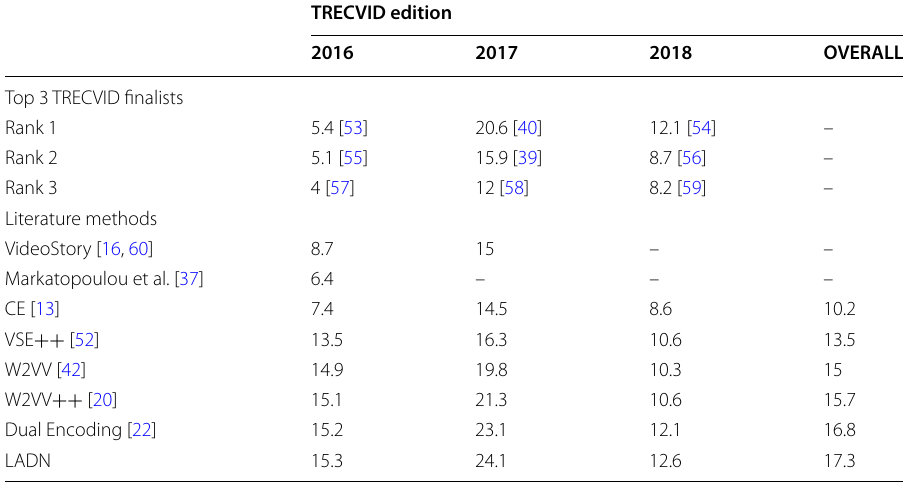
Table 4 Experimental results on TRECVID AVS 2016, 2017, and 2018